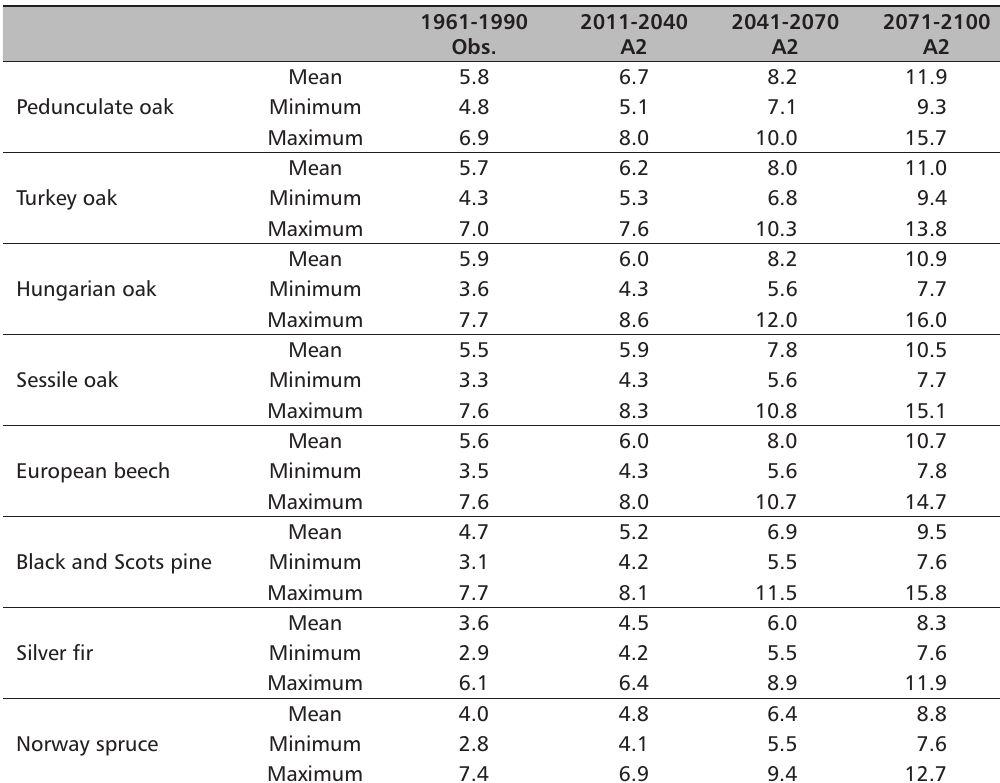
TABLE 1. Mean, maximum and minimum FAI values of current forest distribution in four climatic periods for nine forest tree